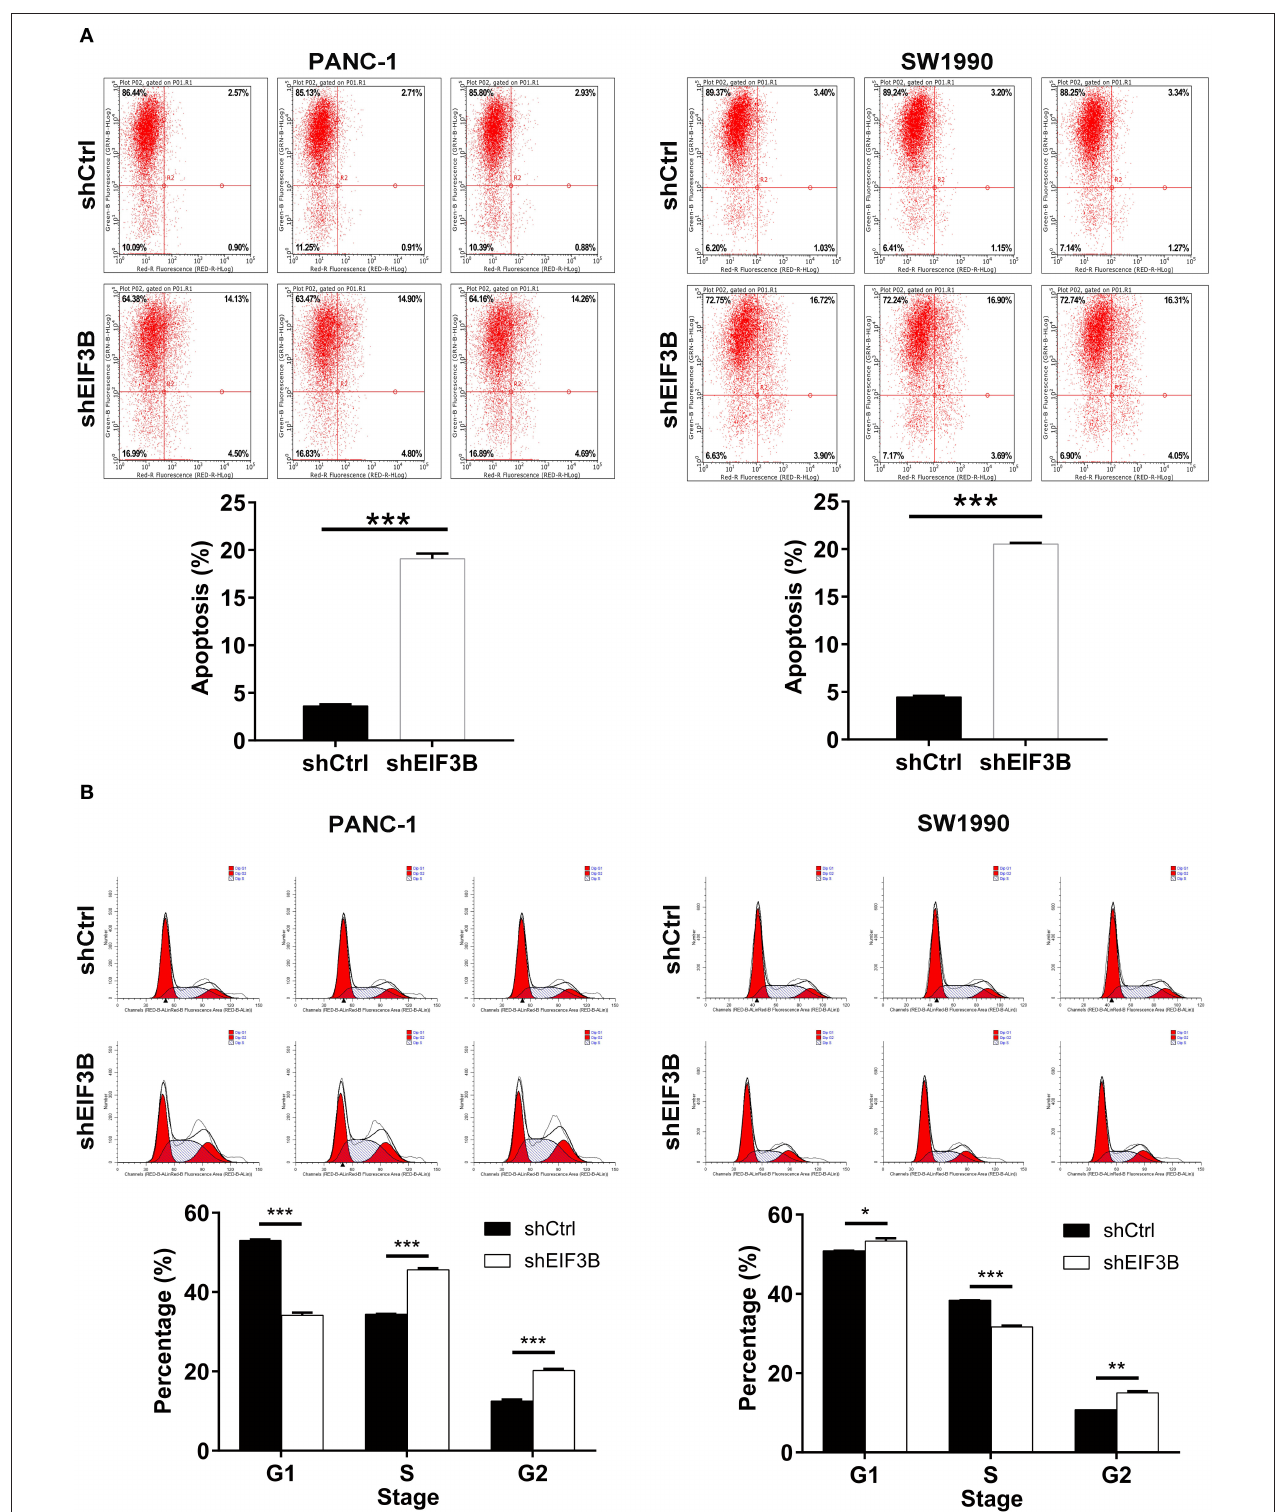
FIGURE 3 | The effects of eukaryotic translation initiation factor 3 subunit B (EIF3B) knockdown on cell apoptosis and cell cycle. (A) The effects of EIF3B knockdown on cell apoptosis were examined by flow cytometry. (B) The effects of EIF3B knockdown on cell cycle were determined by flow cytometry. Results are presented as mean ± SD. * P < 0.05, ** P < 0.01, *** P < 0.001.